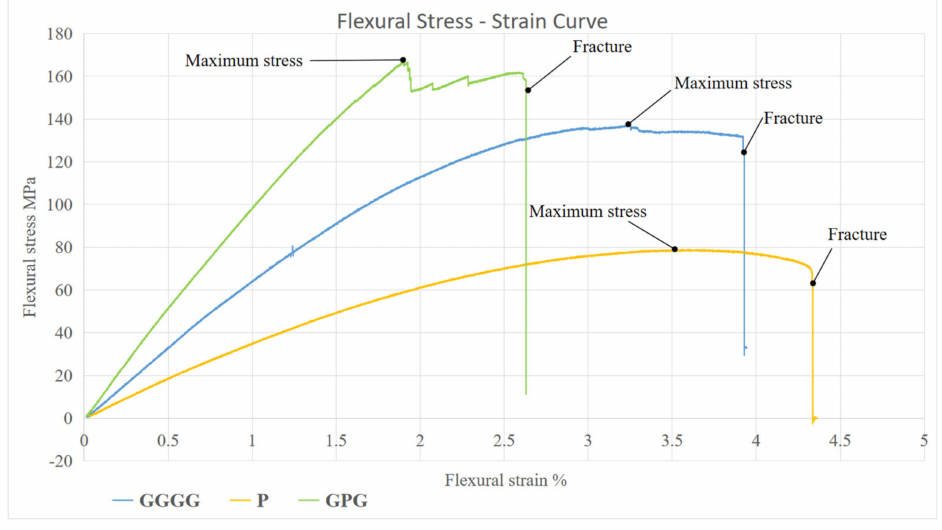
Figure 4. Stress-strain curve of